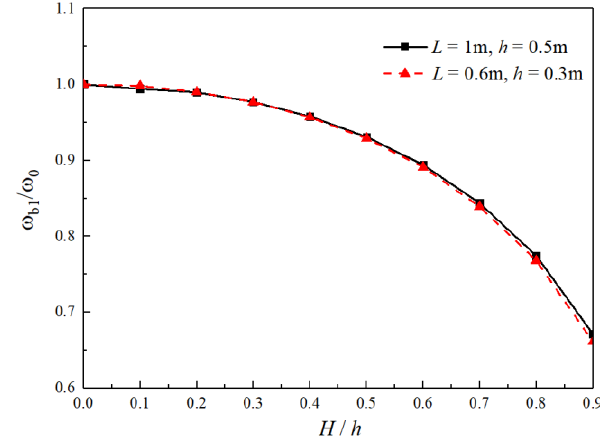
Figure 8. Natural frequency of sloshing in two different sized tanks under different baffle heights.